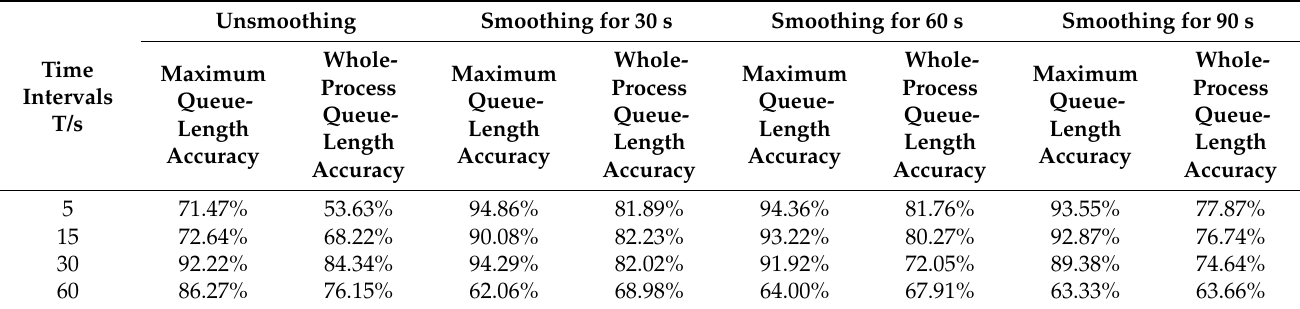
Table 7. Comparison of queue-length